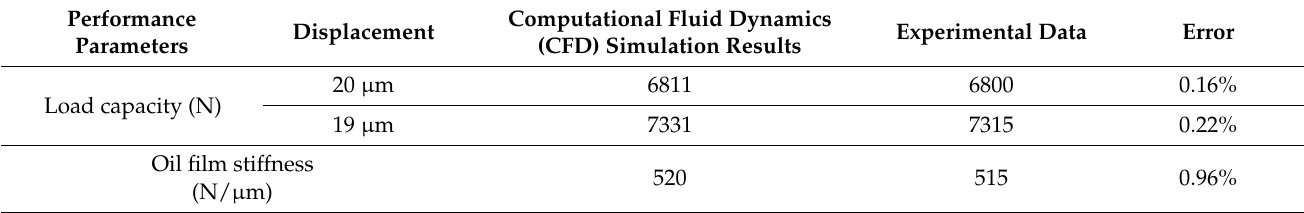
Table 2. Comparisons of performance specifications of the hydrostatic thrust bearing with OLDR of 2 between CFD simulation results and experimental